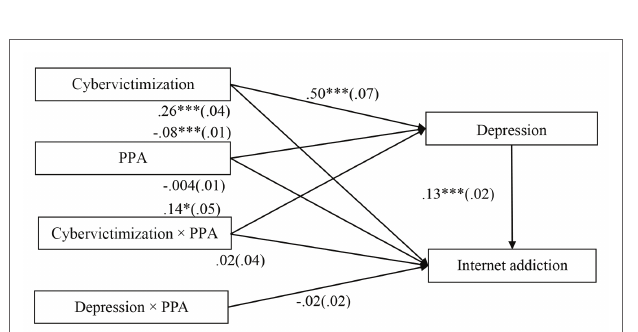
FIGURE 3 | Model of the moderating role of PPA on the indirect relationship between cybervictimization and IA. PPA, prosocial peer affiliation. Values are unstandardized coefficients (outside the brackets) and the standard error is enclosed in parentheses. Paths between gender, age, impulsivity, and each of the variables in the model are not displayed. Of those paths, the following were significant: gender [ b = − 0.16, SE = 0.03, 95% CI ( − 0.21, − 0.11)], age [ b = 0.06, SE = 0.02, 95% CI (0.02, 0.10)], and impulsivity [ b = 0.47, SE = 0.03, 95% CI (0.41, 0.54)] to depression; gender [ b = 0.06, SE = 0.02, 95% CI (0.03, 0.09)] and impulsivity [ b = 0.14, SE = 0.02, 95% CI (0.10, 0.19)] to IA. * p < 0.05, *** p < 0.001.